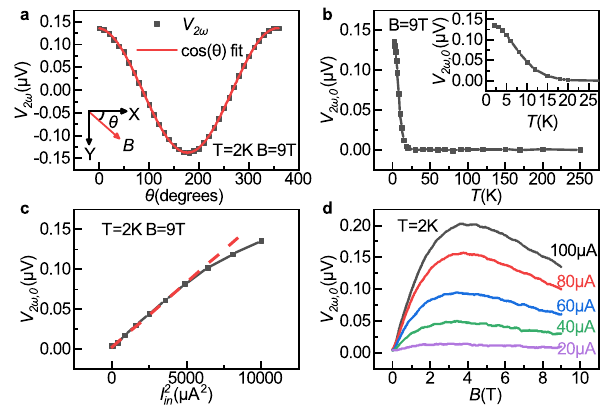
Fig. 2 Second harmonic magnon signal V 2 ω at zero gate current. a V 2 ω as a function of the angle θ between the external magnetic fi eld B and the x direction. Here angle θ is determined the same as shown in Fig. 1c. b Temperature dependence of V 2 ω at θ = 0 ( V 2 ω ,0 ). (Inset: zoom-in view of V 2 ω ,0 low-temperature behavior). c V 2 ω ,0 versus the square of the injection current I 2 . d V 2 ω ,0 versus B at different I in in